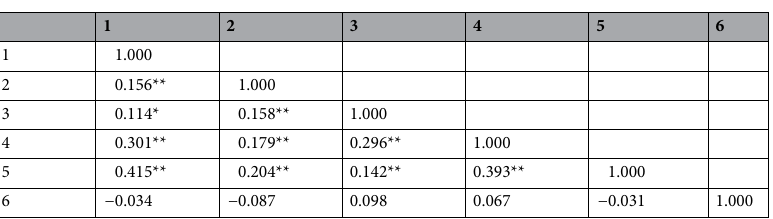
Table 3. Correlation analysis of the relationships between psychological distress and continuous variables. * P < 0.05, ** P < 0.01. 1 = Psychological distress, 2 = Year with COPD, 3 = Frequent acute exacerbation, 4 = mMRC, 5 = CAT, 6 = knowledge of